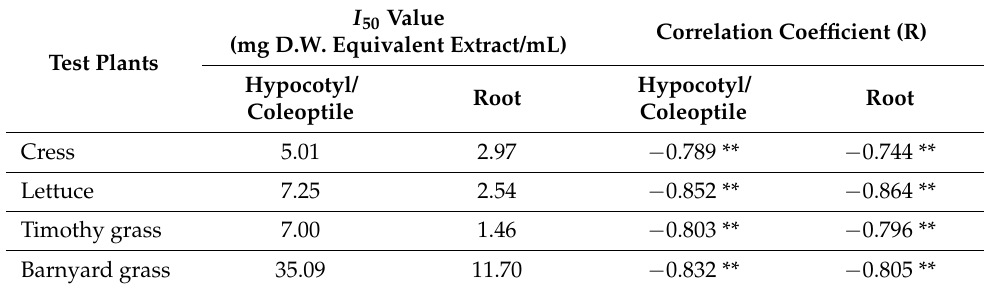
Table 1. I 50 values (concentration of Polygonum chinense extracts required to suppress 50% of seedling growth), and the correlation coefficient (R) between the concentration of the P. chinense extracts and the hypocotyls/coleoptiles and root growth of the four tested